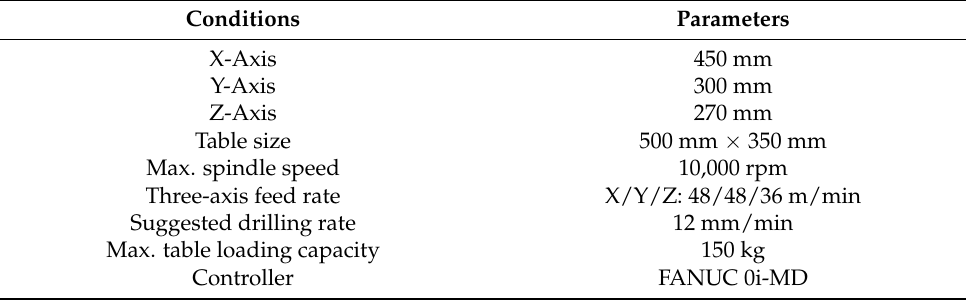
Figure 2. Five-axis CNC processing machine used in this study. Table 1. Parameter settings of the cutting experiments.